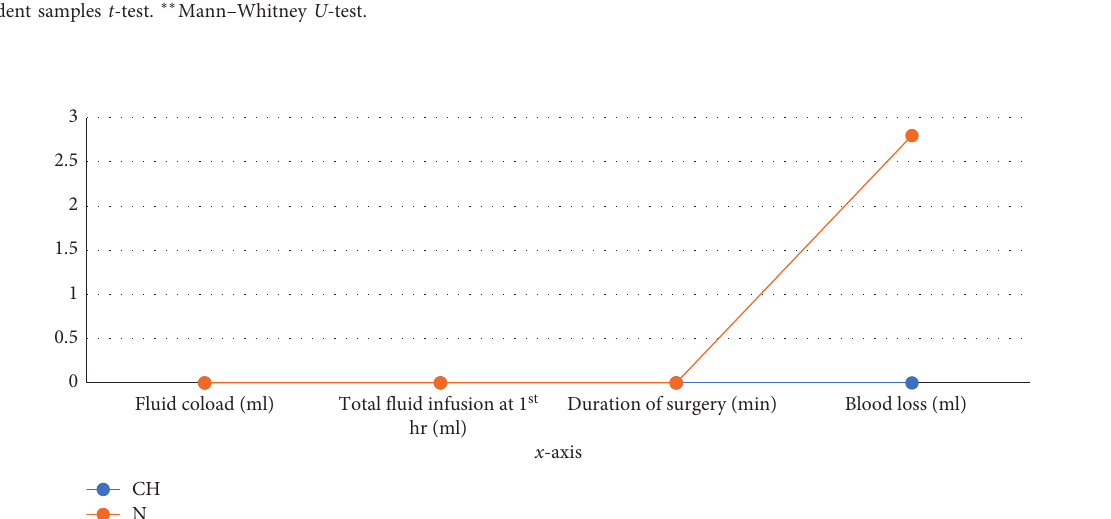
Figure 1: Variation in the fluid coload, total intraoperative fluid used, duration of surgery, and blood loss between the two groups at Black Lion Hospital from October 30, 2019, to January 30, 2020.